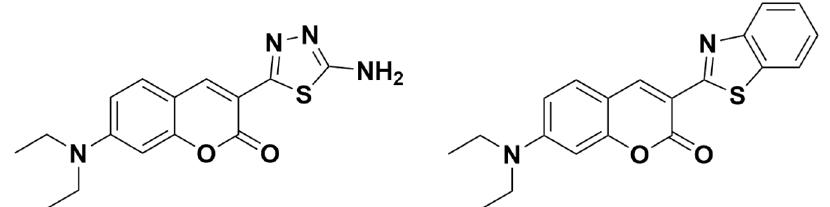
Figure 8. Comparison of structures of highly fluorescent coumarin–thiadiazole hybrid 1 ( left ) and coumarin-derived fluorescence standard Coumarin 6 ( Right ).